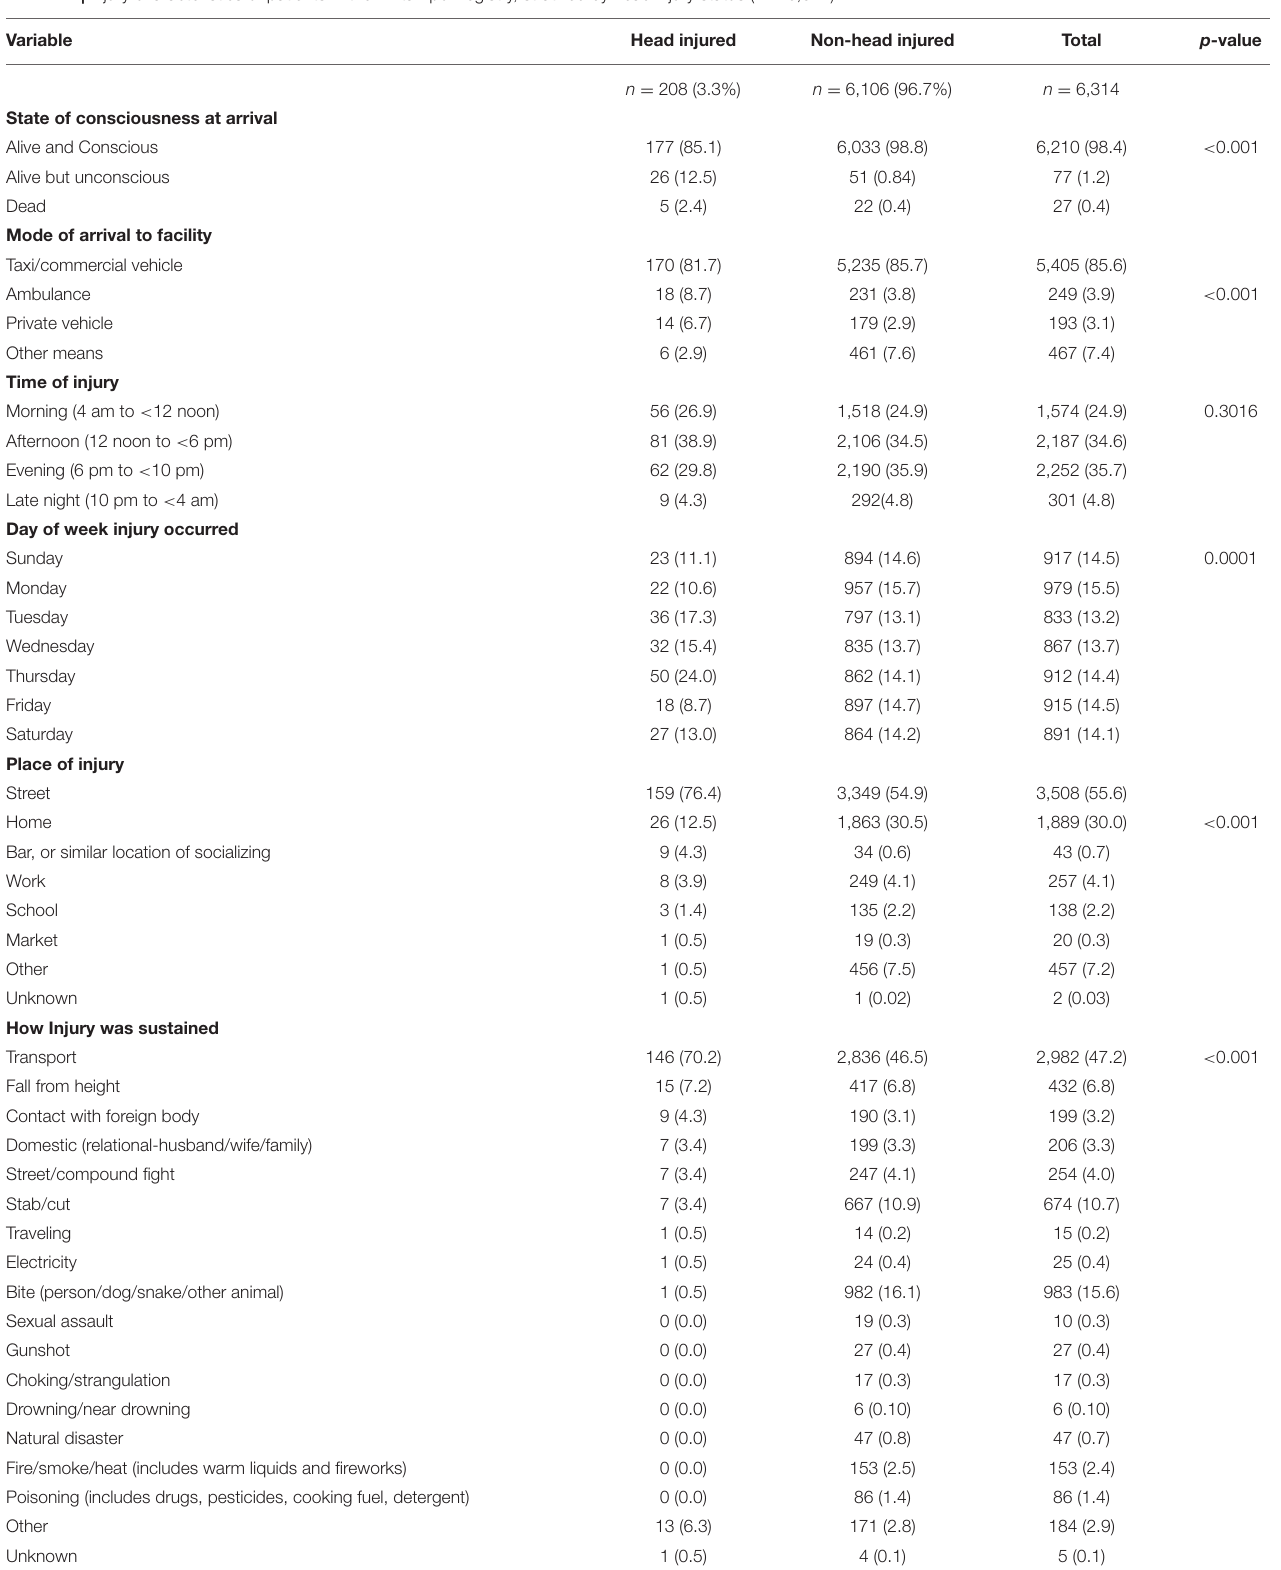
TABLE 2 | Injury characteristics of patients in the Kintampo Registry, stratified by head injury status ( n = 6,314).